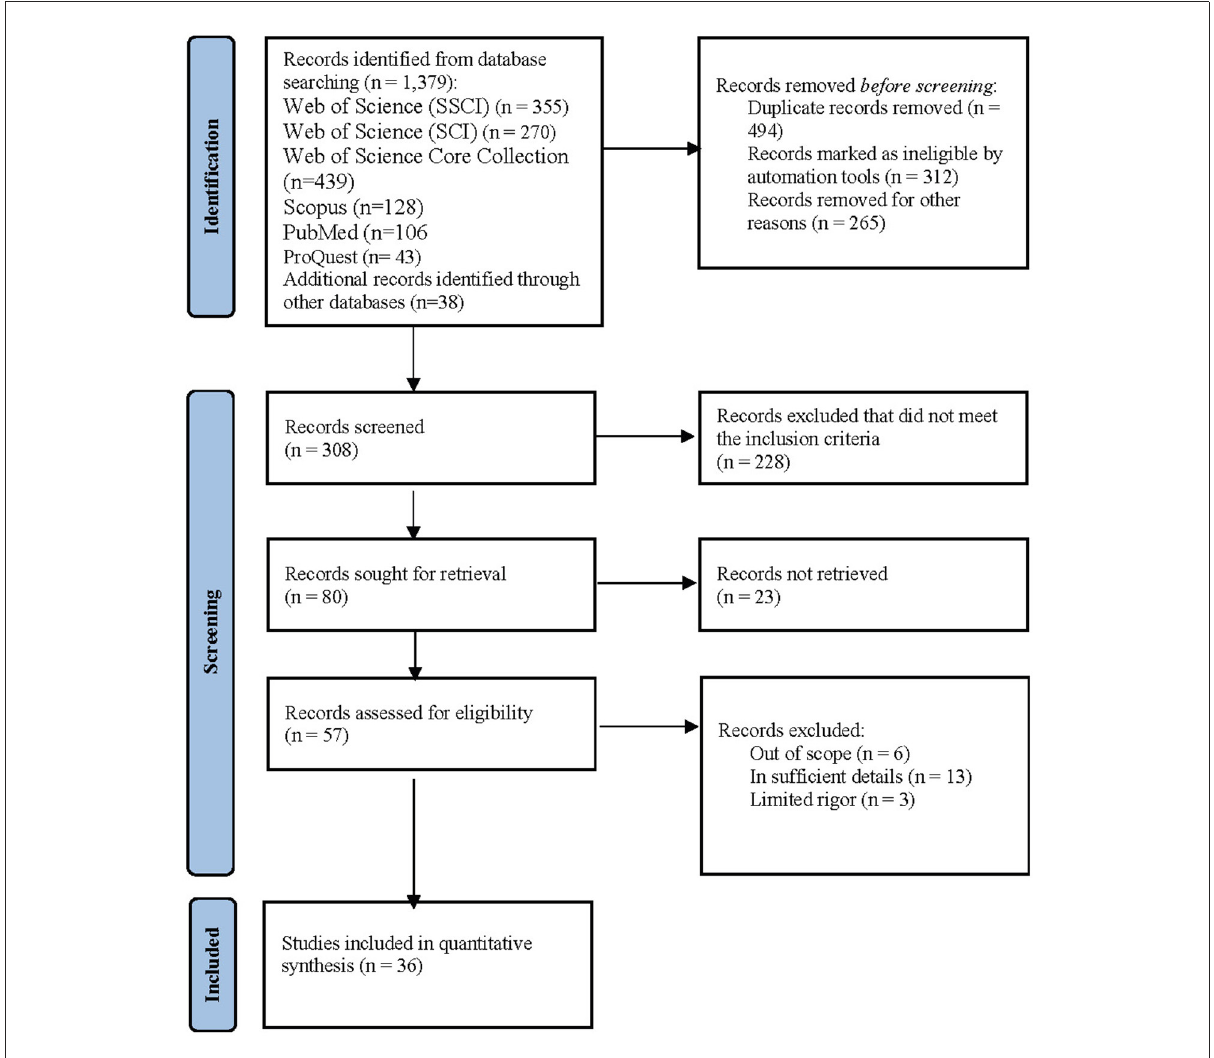
FIGURE1 PRISMA flow